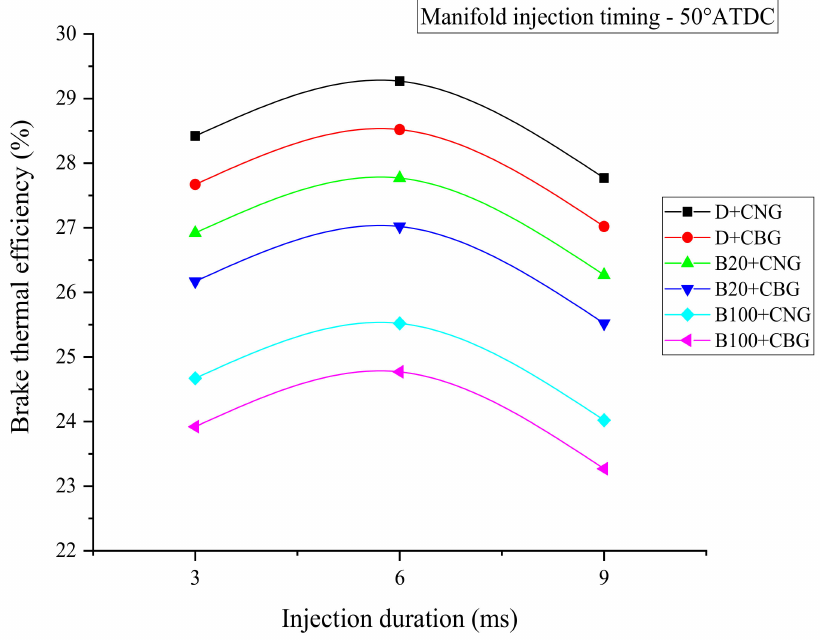
Figure 9. Variation of BTE with